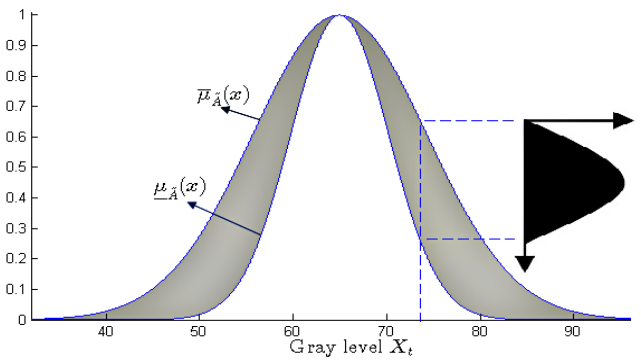
Figure 3. A type-2 fuzzy